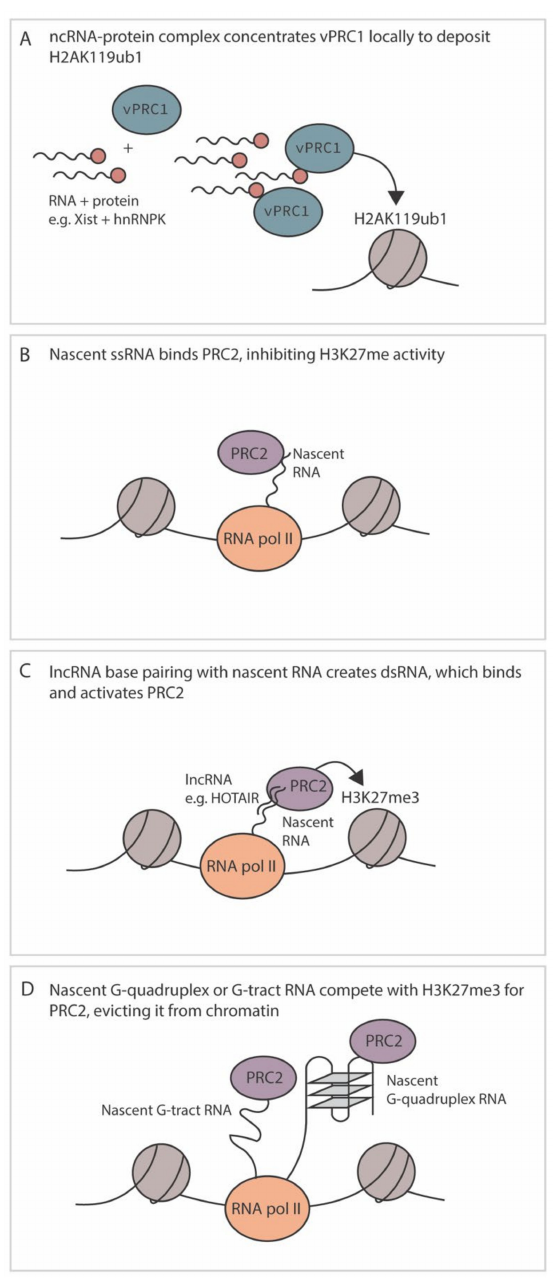
Figure 4. Cellular roles for RNA in modulating polycomb complex binding and facultative hete- rochromatin targeting. ( A ): Non-coding RNA paired with an RNA-binding protein can concentrate variant PRC1 near chromatin and promote subsequent H2AK119ub1 deposition. This has been demonstrated for Xist and hnRNPK. ( B , C ): Nascent RNA being transcribed by RNA polymerase II can inhibit PRC2 activity, but dsRNA formation by lncRNA base pairing to the nascent RNA can activate PRC2. HOTAIR is one such lncRNA. ( D ): Nascent G-tract or G-quadruplex RNA have high binding affinity for PRC2, and can thus compete with H3K27me3 for PRC2 binding. PRC2 is evicted from the chromatin as a result of this